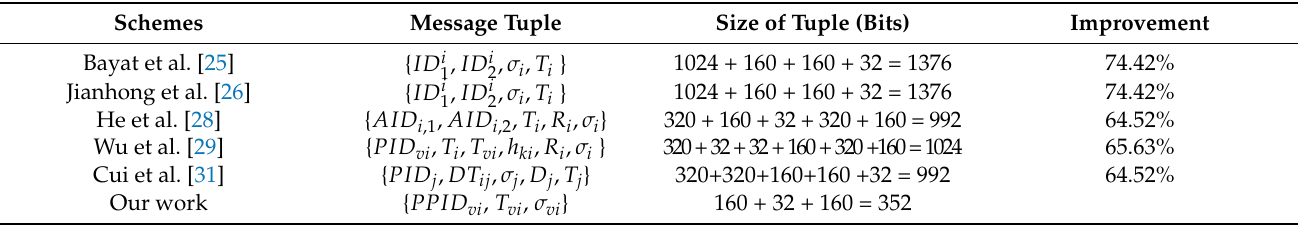
Table 6. Comparison of cost of